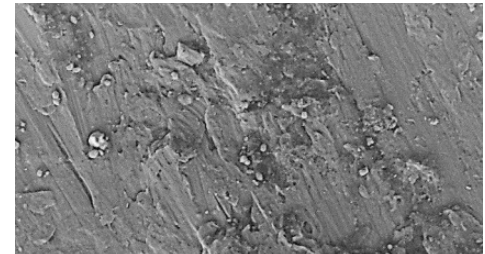
Figure 9. Corrosion rate of 5% with constant A6061 95% of